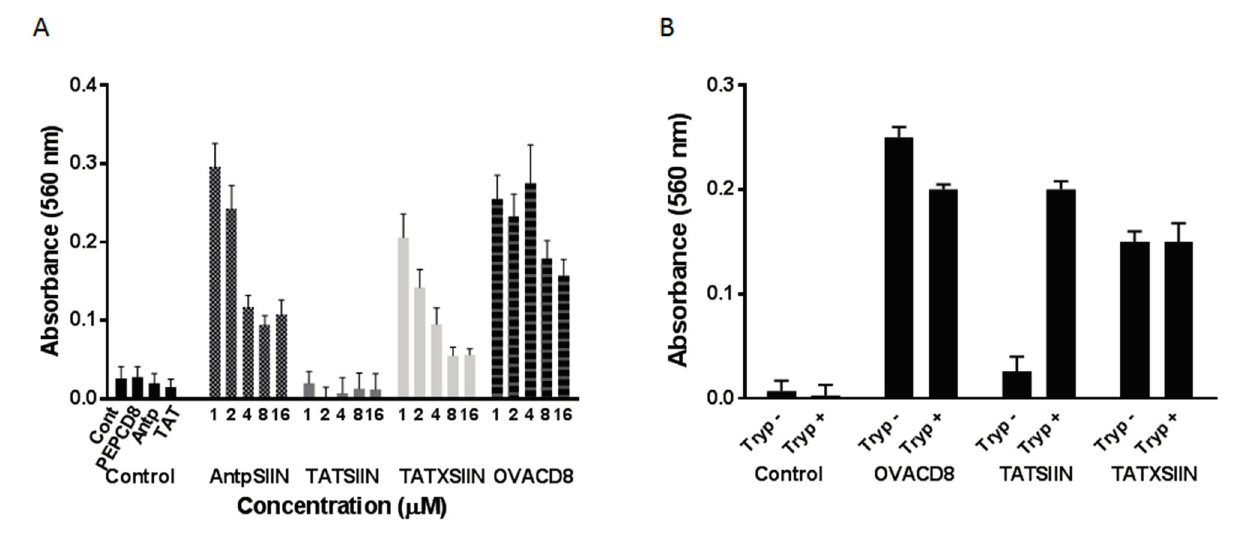
Figure 4. ( A ) In vitro stimulation of SIINFEKL-specific T cells by AntpSIIN, TATSIIN and TATXSIIN pulsed DC2.4. Cells were incubated with the peptide antigens for 8 h and added to B3Z T cells for 18 h. Controls included cells alone, Antp, OVACD8 (SIINFEKL) and PEPCD8, a non-internalising peptide; ( B ) In vitro stimulation of SIINFEKL-specific cells by DC2.4 cells pulsed with tryptic digests (Tryp) of TATSIIN, TATXSIIN and SIINFEKL. Cells were incubated with the tryptic digests as in A. In both ( A ) and ( B ), LacZ activity in B3Z T cells was assayed by total culture lysates with LacZ substrate CPRG. The absorbance (560 nm) of chlorophenol red released by β -galactosidase was read after 4 h incubation at 37 °C. Values show the mean ± SEM for 4